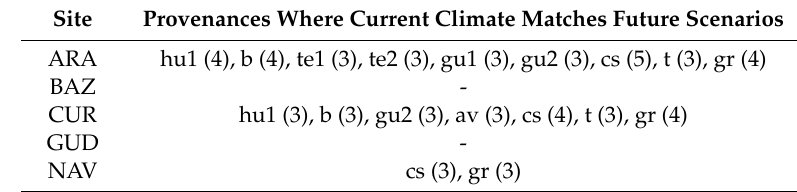
Table 5. Provenances within the range of future conditions up to 2050 of each experimental site for at least three of the climatic indices (in brackets, number of indices matching future conditions. See Appendix A for details and Table